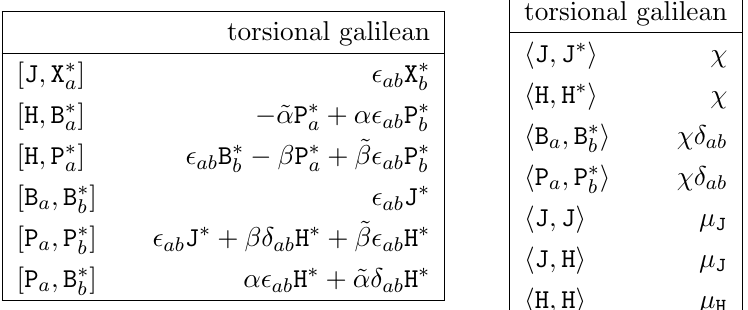
stands for B (cid:3) ; P (cid:3) . The metric a a a